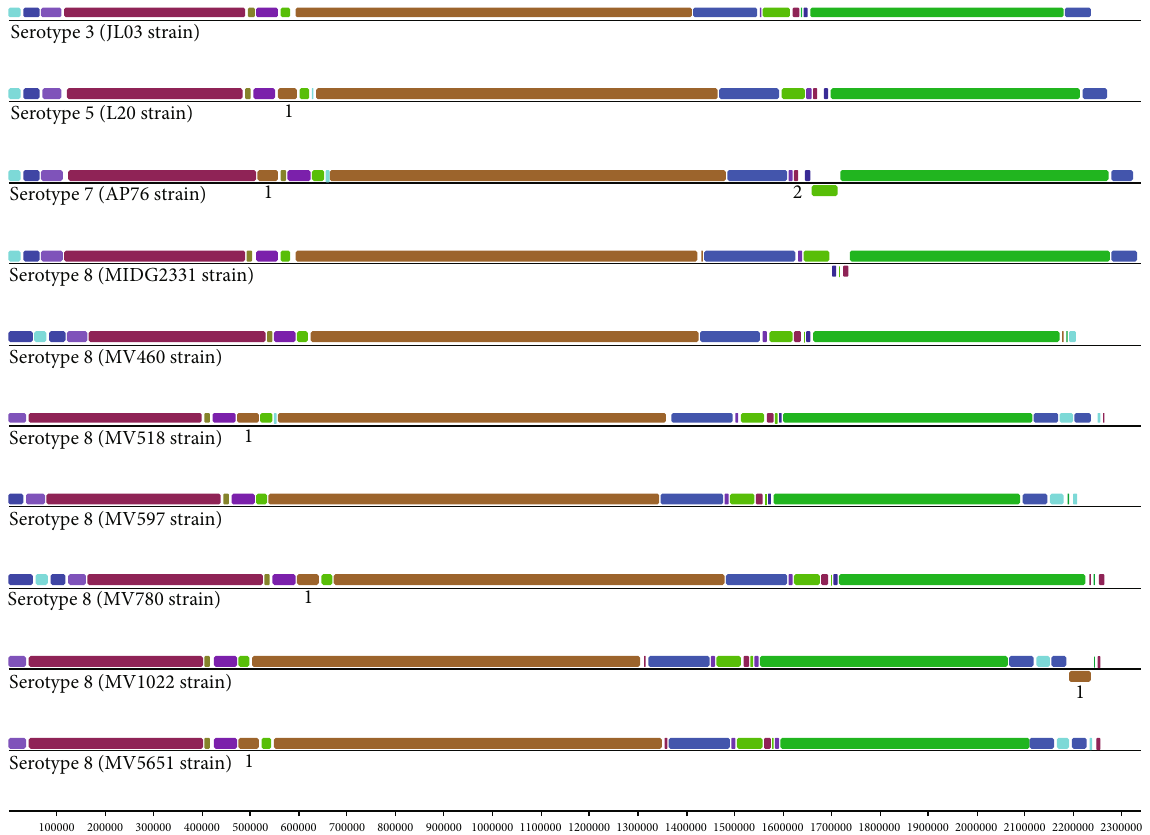
Figure 3: Synteny analysis of A. pleuropneumoniae genomes. The genomes represented correspond to serotype 3 (JL03 strain), serotype 5 (L20 strain), serotype 7 (AP76), and serotype 8 (MIDG2331, MV460, MV518, MV597, MV780, MV1022, and MV5651 strains). Horizontal bars represent the size of the genome (kb). The region identi fi ed in 1 represents the acquisition and loss of genomic information, and region 2 represents a recombination